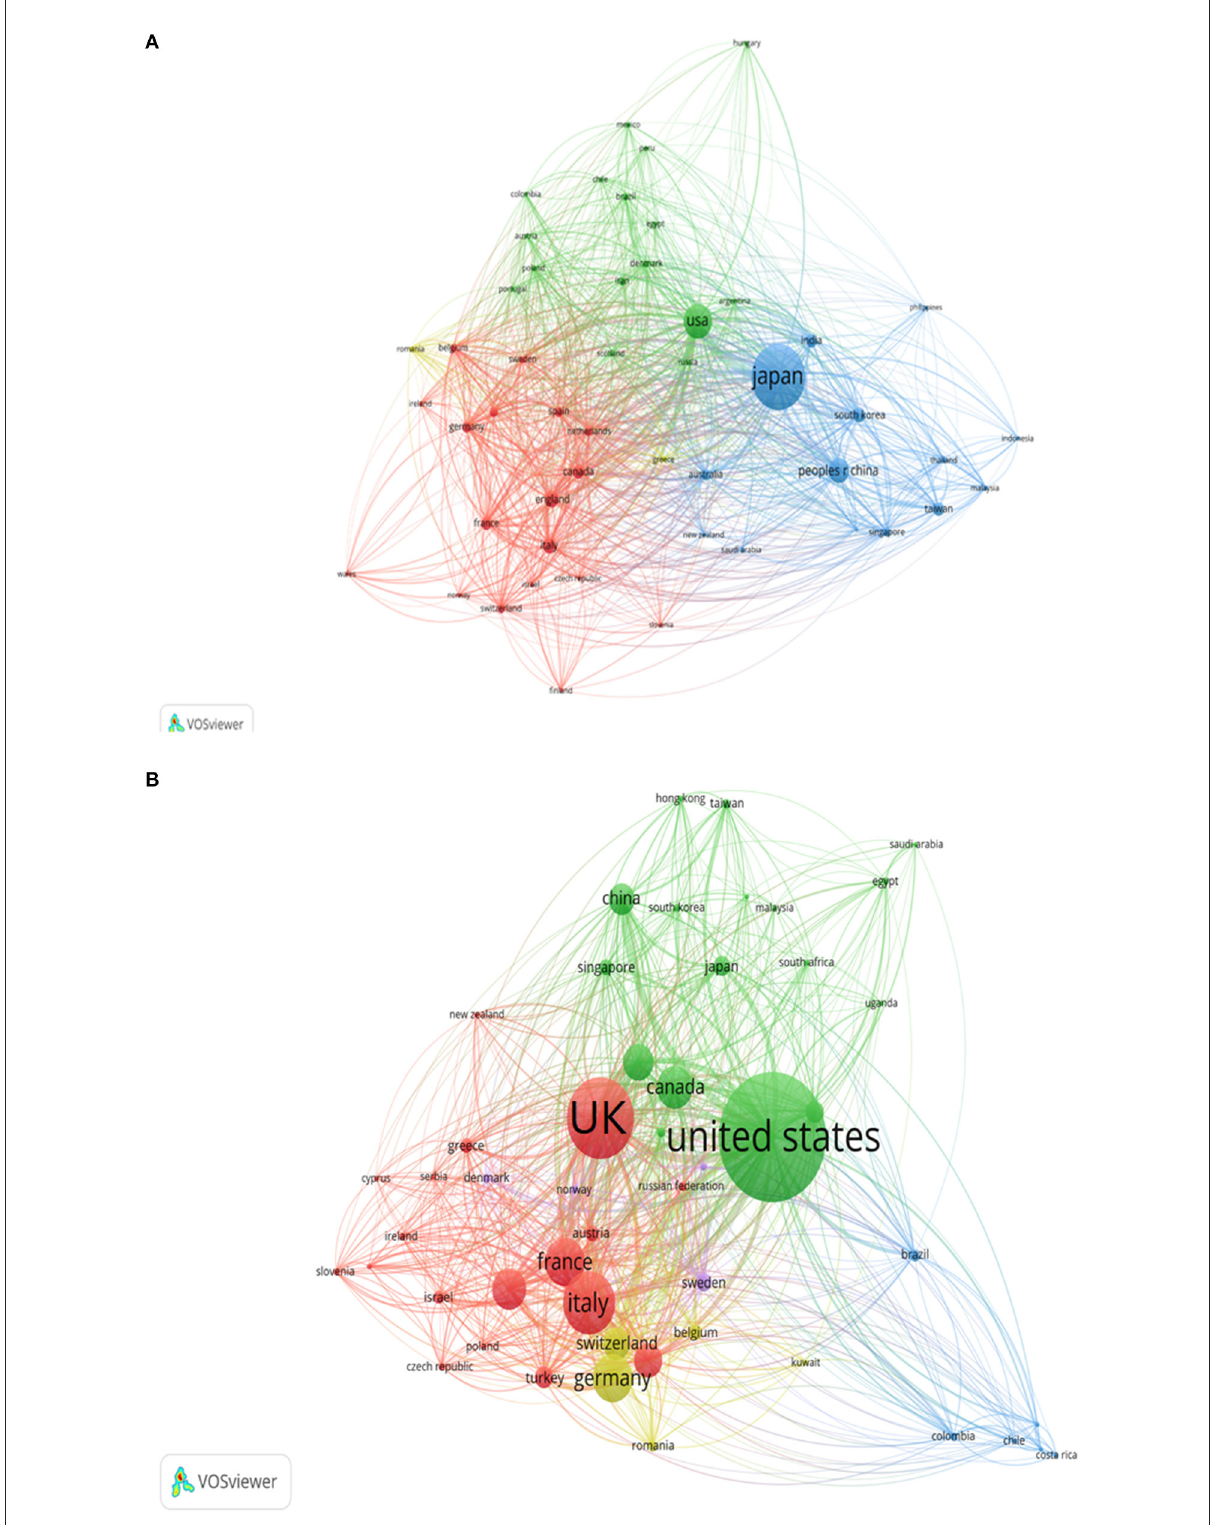
FIGURE5 Network visualization of collaborations among countries of KD research in WOS (A) and Scopus (B)